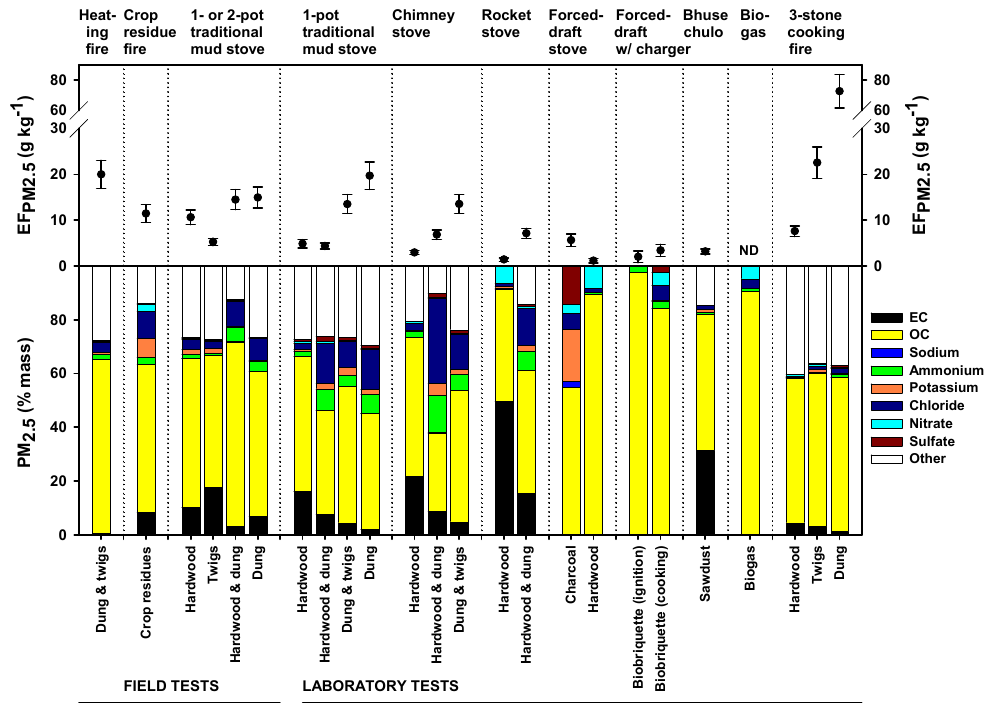
Figure 4. EF PM and PM 2 . 5 composition (as percent by mass) for various types of biomass burning, including open burning (heating and 2 . 5 crop residue fires), cooking stoves, and three-stone fires. Within a stove type, fuels are positioned with increasing dung content, revealing that burning or co-burning of dung yielded higher PM 2 . 5 emissions. Error bars correspond to analytical